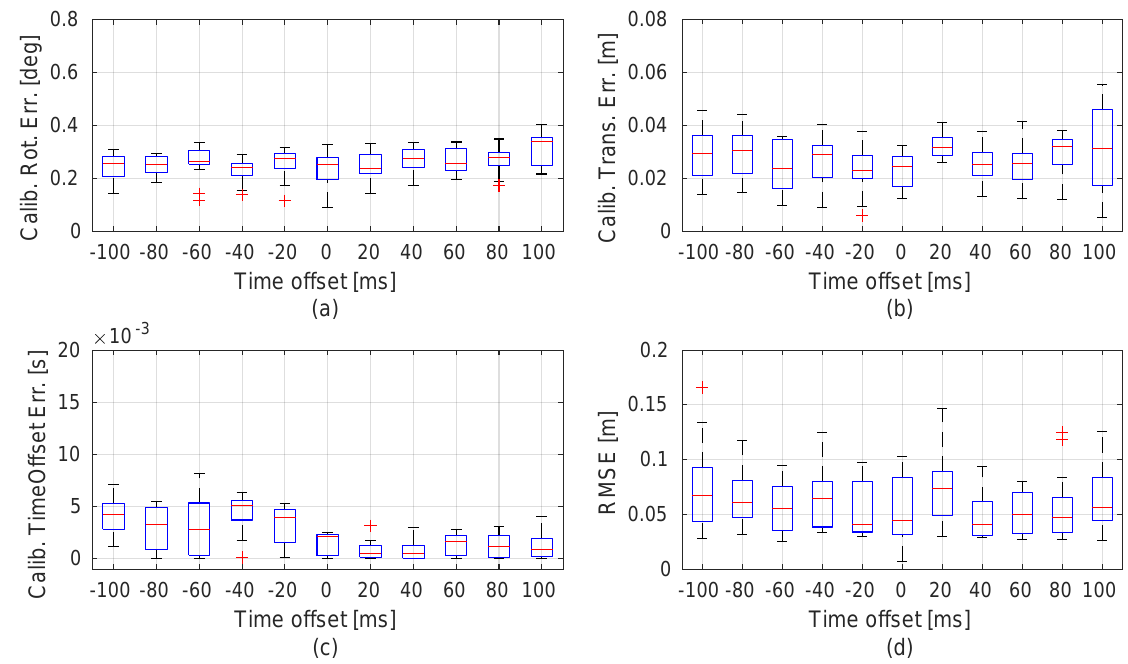
Figure 8. Statistical visualizations of the spatial-temporal calibration errors ( a – c ) and trajectory accuracy ( d ) under various time offsets using the MH_03 sequence. The x-axes of the subplots show the various time offsets. The box plots are the results of 25 tests using randomly selected start